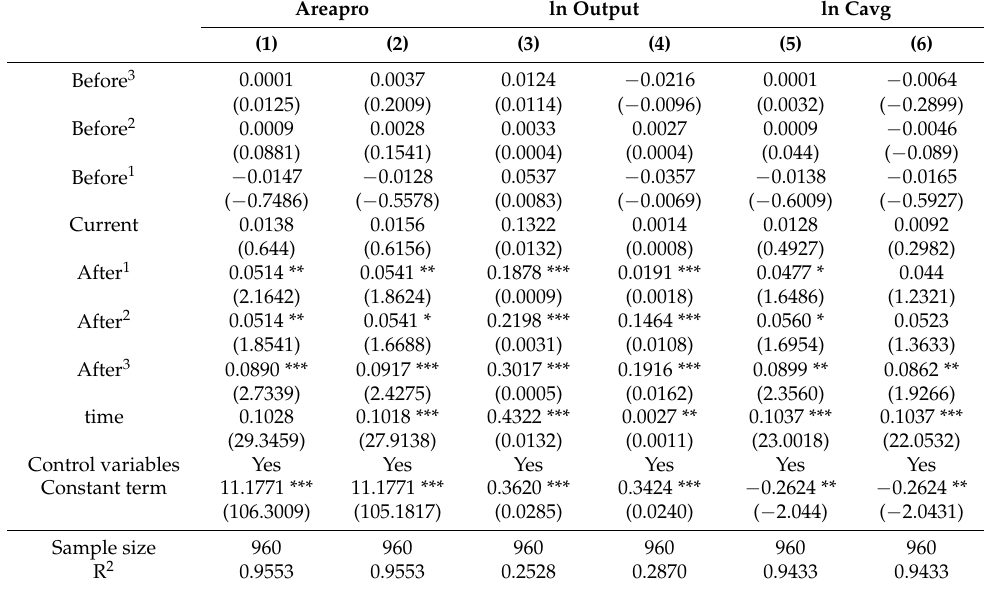
Table 5. Parallel trend test